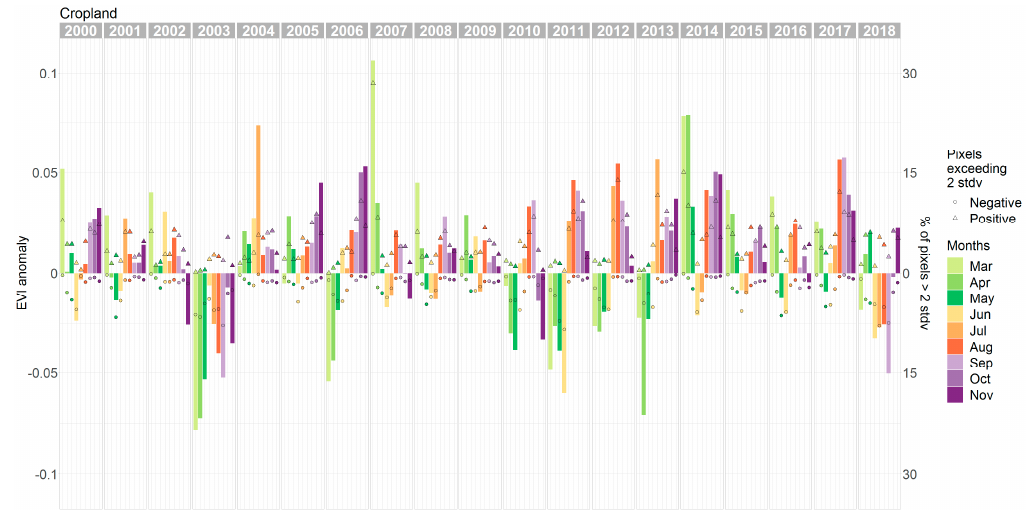
Figure 5. Monthly averaged EVI anomalies for cropland and percentage of pixels with EVI deviances exceeding two standard deviations (pixel-based) positively and negatively per month for Germany for the years 2000–2018 for cropland.